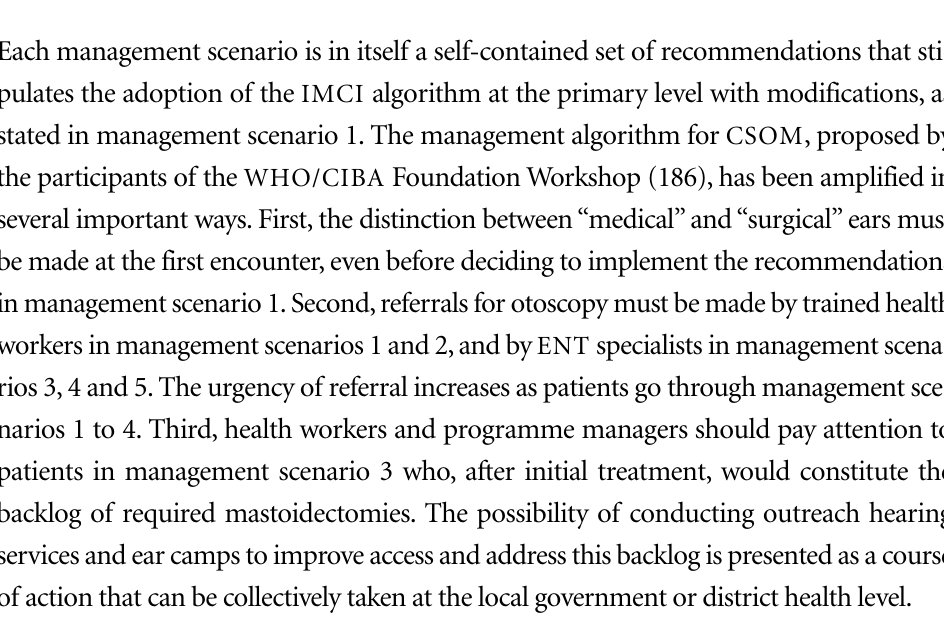
Fig. 4. Management Scenario Algorithm Patient with ear discharge of 2 weeks or